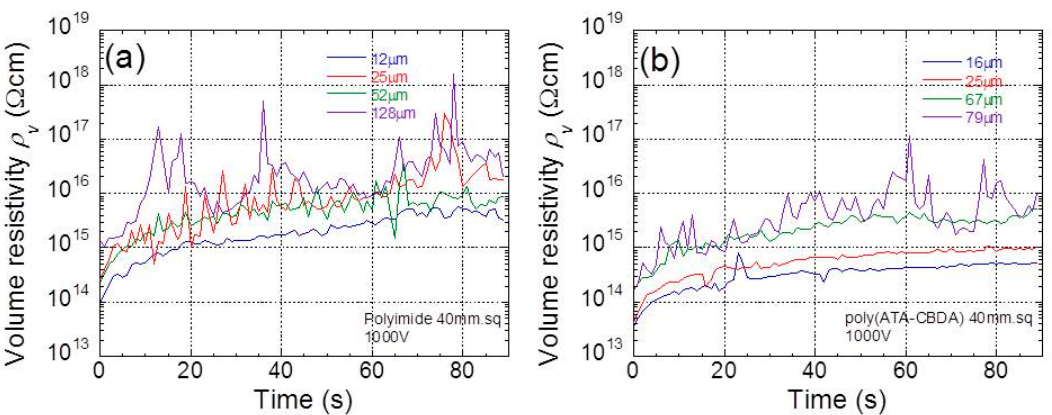
Figure 4. Time profiles of electric resistivity at 1000 V for ( a ) polyimide and ( b ) biopolyimide films with various thicknesses.